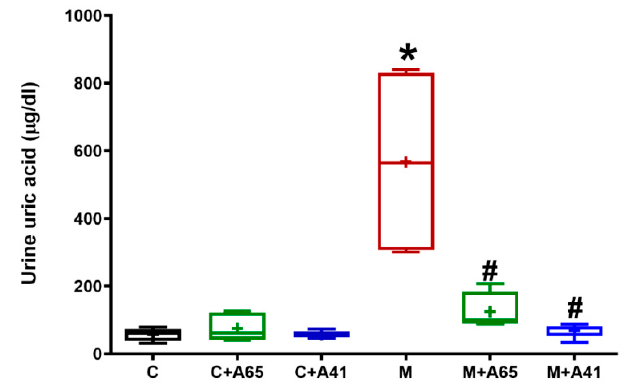
Figure 4. The CB1 receptor antagonists AM6545 and AM4113 blocked the tenfold elevation in urine uric acid content in high-fructose high-salt induced metabolic syndrome rats. The concentration of uric acid was measured in urine of the control (C) and metabolic syndrome (M) rats as well as control and metabolic rats treated with AM6545 (C + A65) and (M + A65) respectively or AM4113 (C + A41) and (M + A41) respectively at a dose of 10 mg/kg/day. Results are shown as box plots and the mean is shown as (+) ( n = 8). * p < 0.05 relative to the control group and # p < 0.05 relative to the metabolic syndrome group by one-way ANOVA followed by Tukey’s post hoc test.